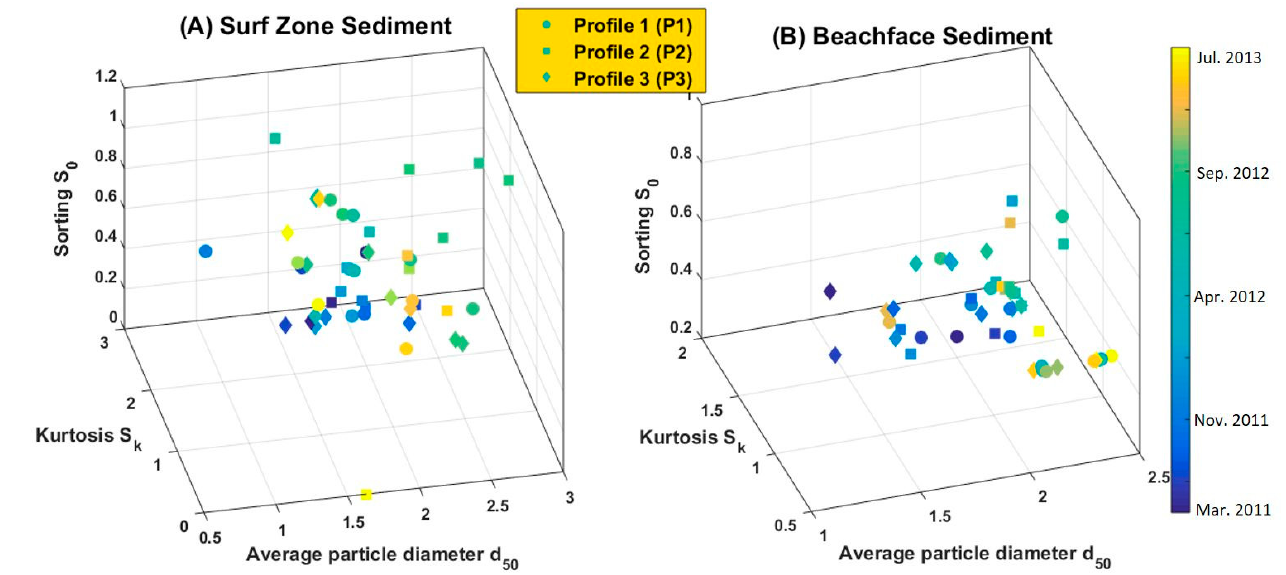
Figure 8. Beach profiles, Tubul Bay. The beach profiles were surveyed in postearthquake conditions on a seasonal basis (winter-summer). They present wide variability ( A , B ), with the exception of profile 3 ( C ), which is located in a more pro- tected area of the bay. See Figure 2A for the location of each profile.